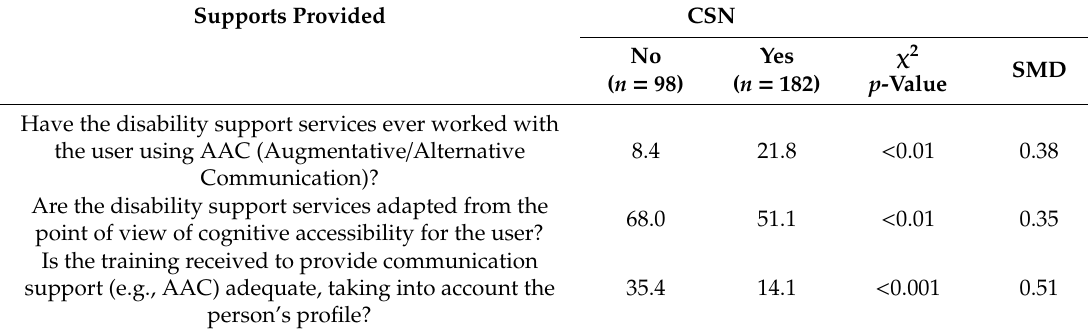
Table 9. Percentage of yes responses as a function of communication support